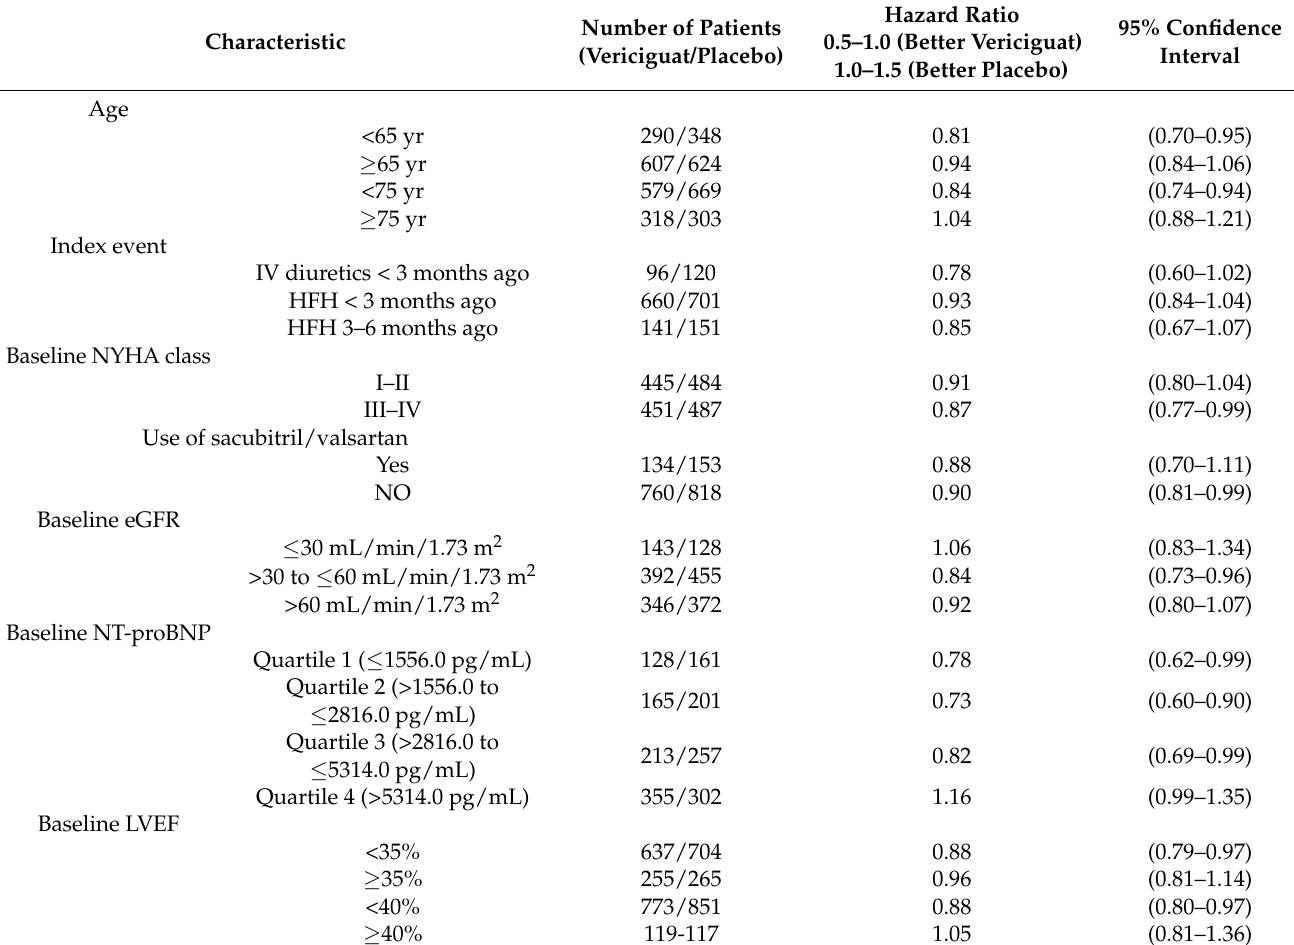
Table 3. Subgroup analysis of the VICTORIA